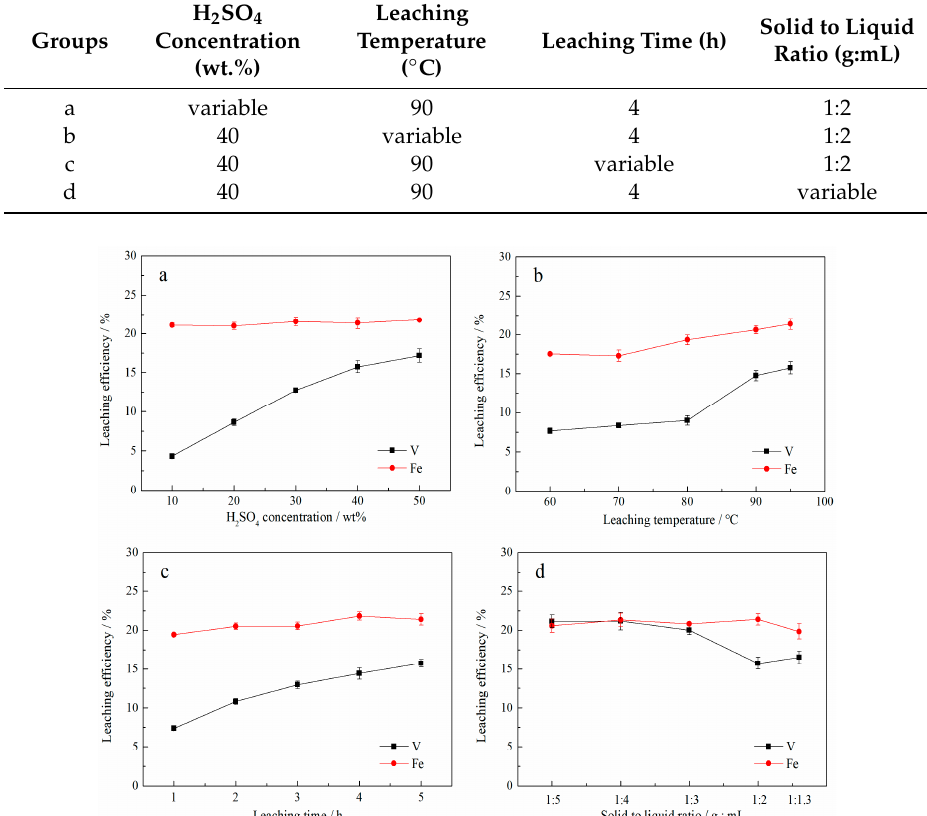
Table 1. The experimental parameters in the leaching of the raw ore and the roasted ore.